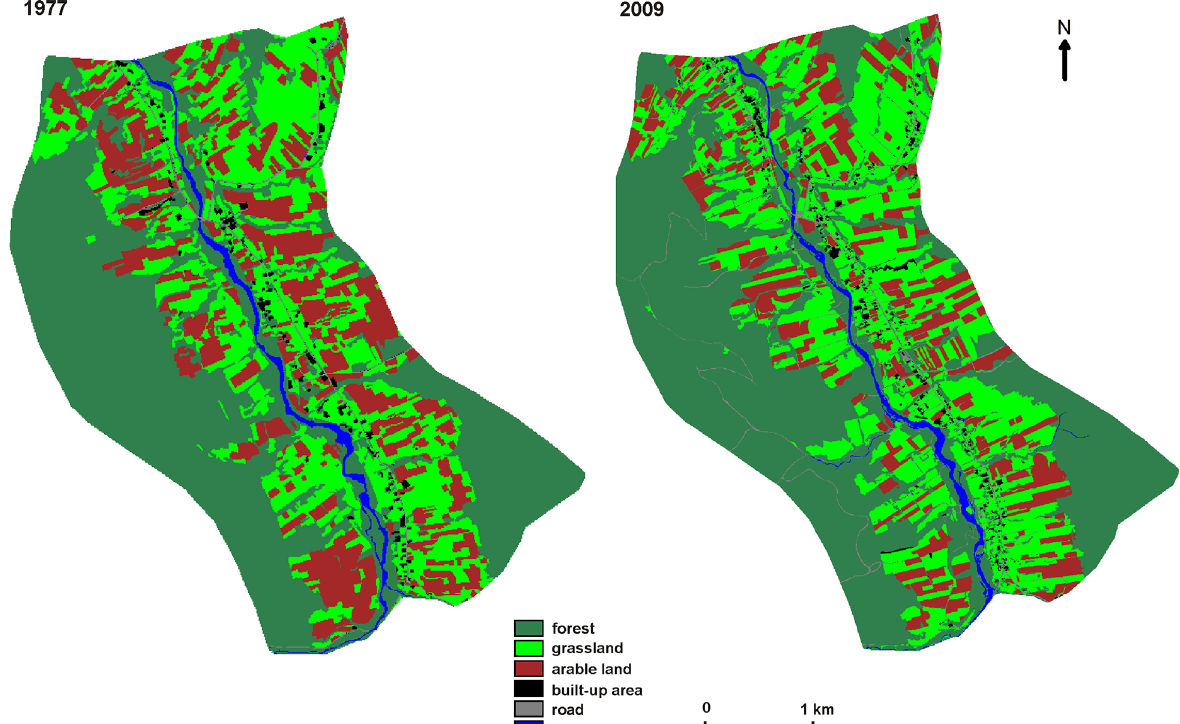
Fig. 4. land use in the Biała river valley in 1977 and